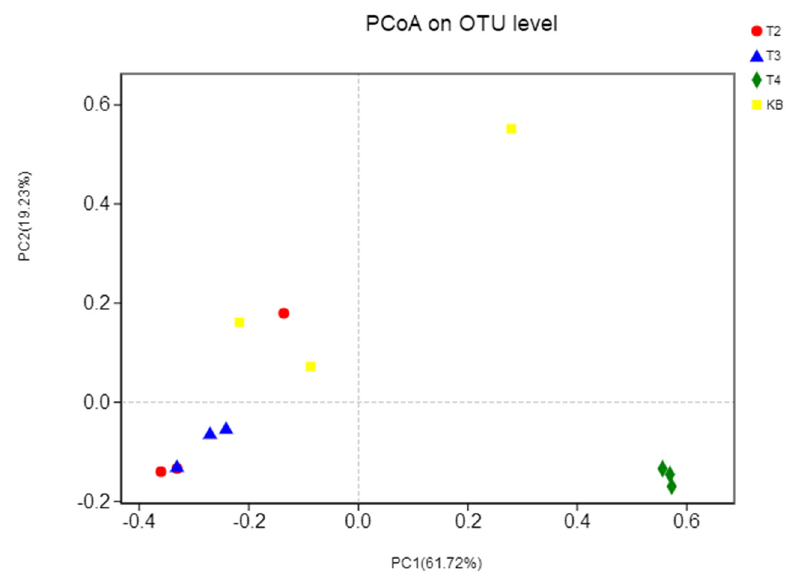
Figure 4. Principal component analysis (PCoA) diagram of the 16S rRNA gene sequencing data based on bistriazine ring derivative wastewater.